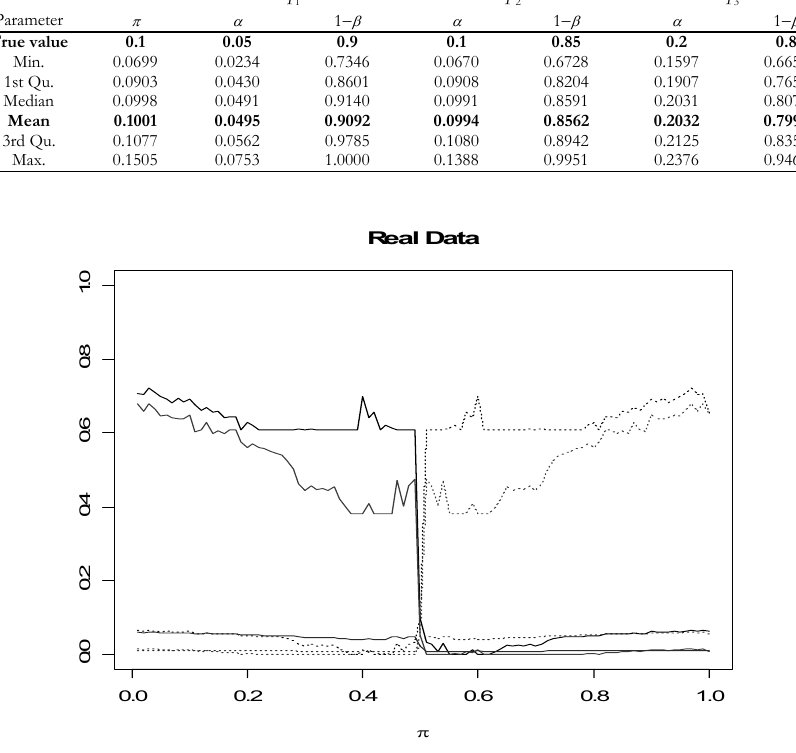
Figure 3 – Results of the optim function with L-BFGS-B minimization algorithm on the observed data. Dotted lines are type I errors and solid lines represent the powers of each diagnostic test. IDEXX = black lines; Pourquier = red lines, and FdC = blue lines.